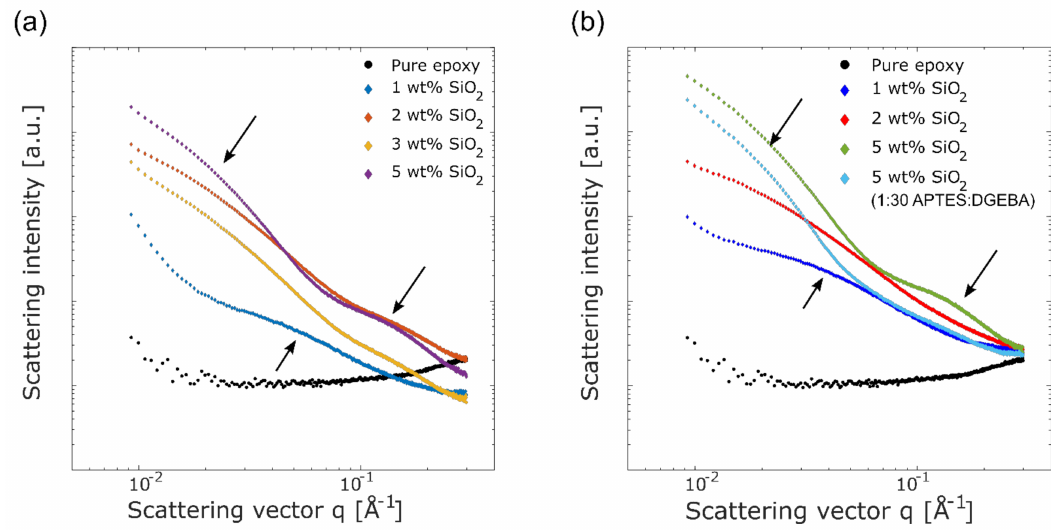
Figure 4. SAXS profiles for pure epoxy and epoxy-SiO 2 nanocomposites with APTES synthesized with ( a ) pH 7 and ( b ) pH 11. The sample prepared with an APTES:DGEBA ratio of 1:30 at pH 11 is also included in ( b ). The features in the scattering pattern for the nanocomposites (shown by the arrows) indicate a hierarchical structure in the SiO 2